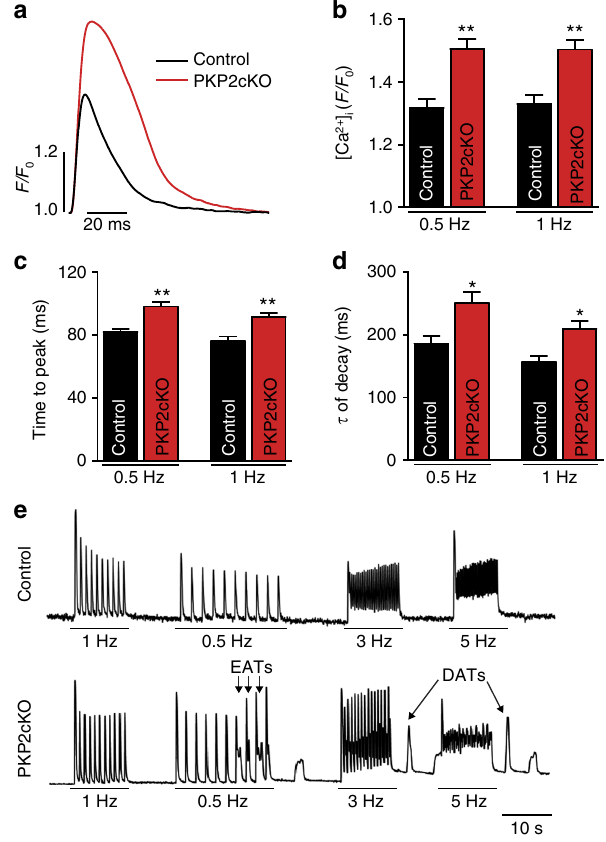
Fig. 9 Ca 2+ transients in PKP2-cKO cardiomyocytes at 21 dpi. a Ca 2+ transients from control ( black ) and PKP2-cKO ( red ) cardiomyocytes paced at 1 Hz. b – d Quanti fi cation of time to peak ( b ), amplitude ( c ) and relaxation time constant ( d ) of calcium transients from ventricular myocytes paced at 0.5 and 1 Hz from control ( n = 26; three mice) and PKP2-cKO ( n = 50; three mice) cardiomyocytes. Student ’ s t -test, * p < 0.05, ** p < 0.01 vs. control. e Examples of Ca 2+ transients in control ( top ) and